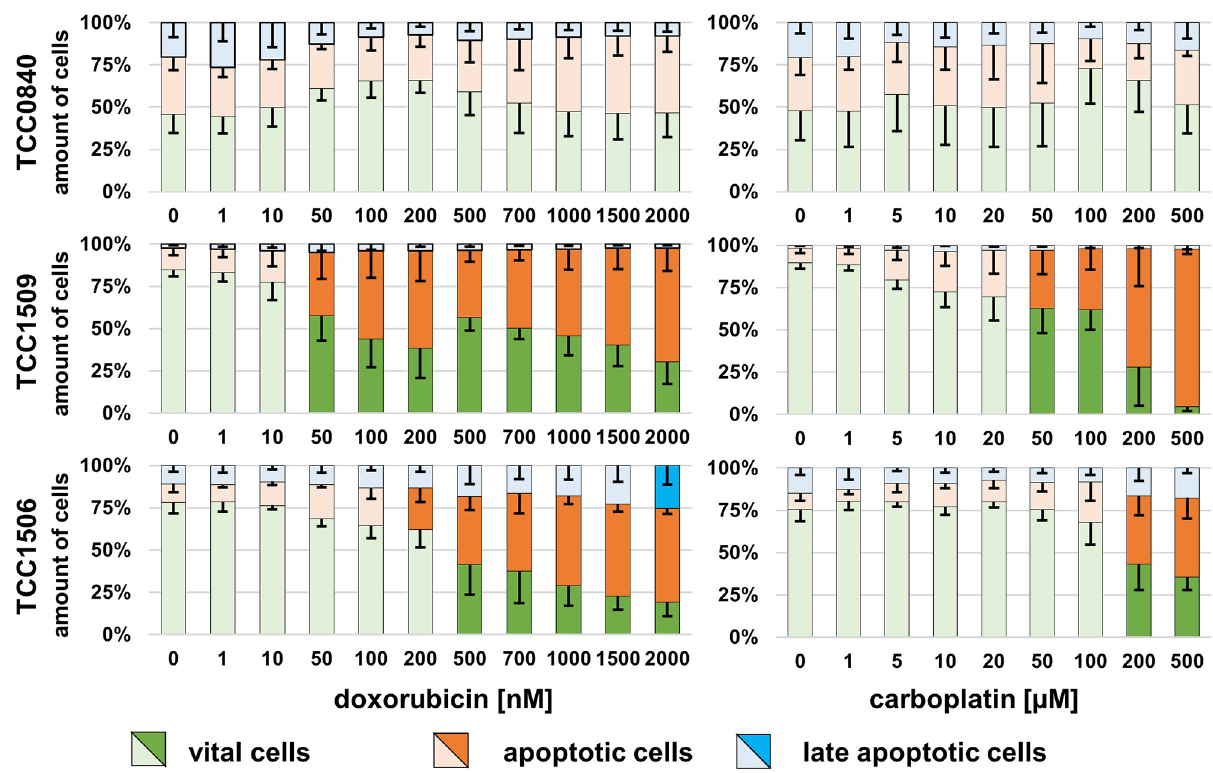
Fig 8. Induction of apoptosis in TCC cell lines after 72 h incubation with doxorubicin or carboplatin. Vital (green), apoptotic (orange) and late apoptotic (blue) proportions of TCC cell lines; means and standard deviations are displayed. Dark colours display significant differences referred to untreated controls. � p < 0.05; n = 4.